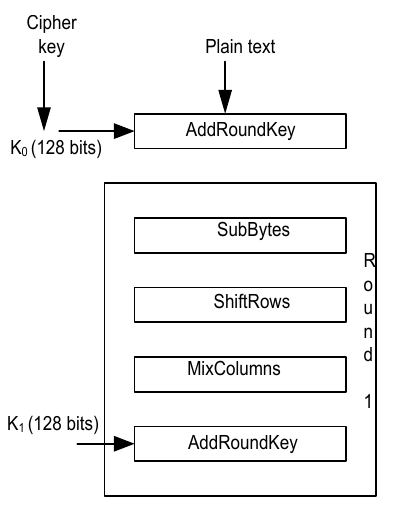
Figure 3. AES algorithm architecture for key size of 128 bits